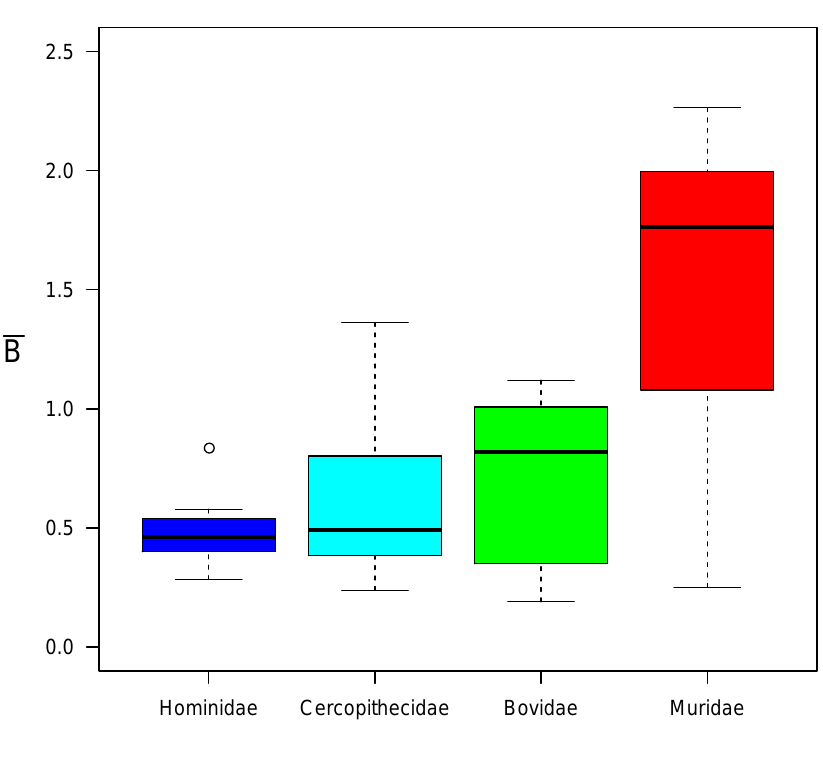
Figure 3 – Distribution of the average estimated B (M3sh model). One outlying data point is missing from the figure: the estimated average B was 3.86 in the ( Capra hircus , Ovis aries ) ancestral branch